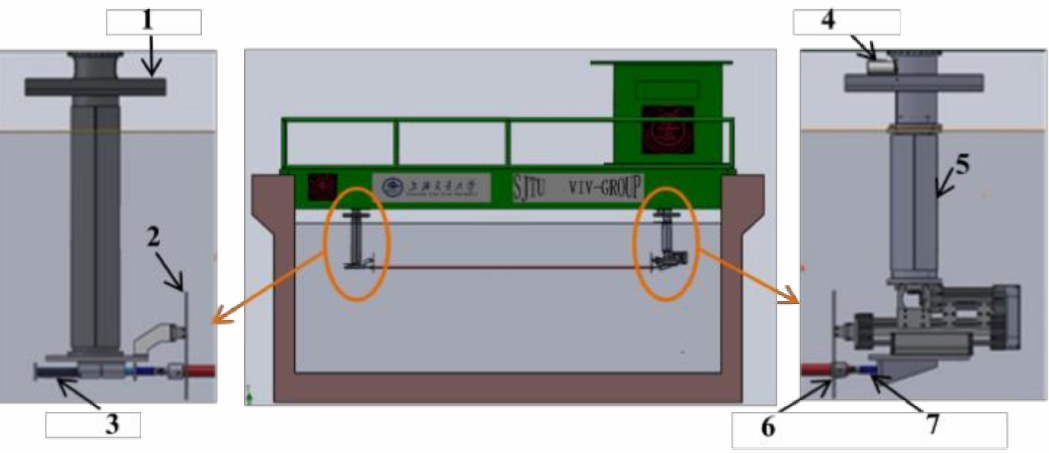
Figure 1. The test device of riser in uniform flow. (1. wave suppression plate; 2. baffle; 3. buffering spring; 4. servo motor; 5. support column; 6. cardan joint; 7. force sensor.)